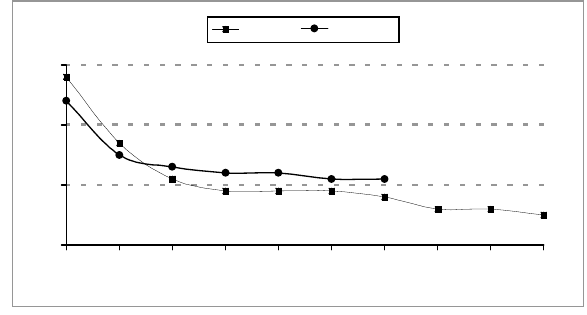
Fig. 3 - Voltage strength-duration curves for acute myocardial stimulation threshold of a human fetus during lead implant and first postoperative day (POD). The acute fetal myocardial stimulation thresholds were consistently low, with no stimulation failure seen with the new electrode. The curve remained relatively constant at pulse widths greater than 0.6 msec, turning sharply upward with shorter pulse widths less than 0.6